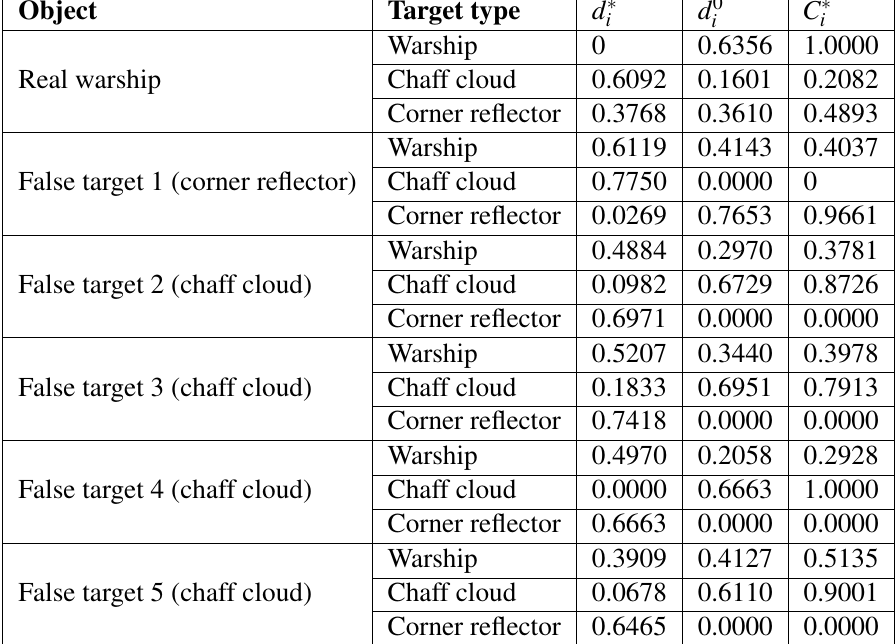
Table 2 Distance of each class to the ideal spot and negative ideal